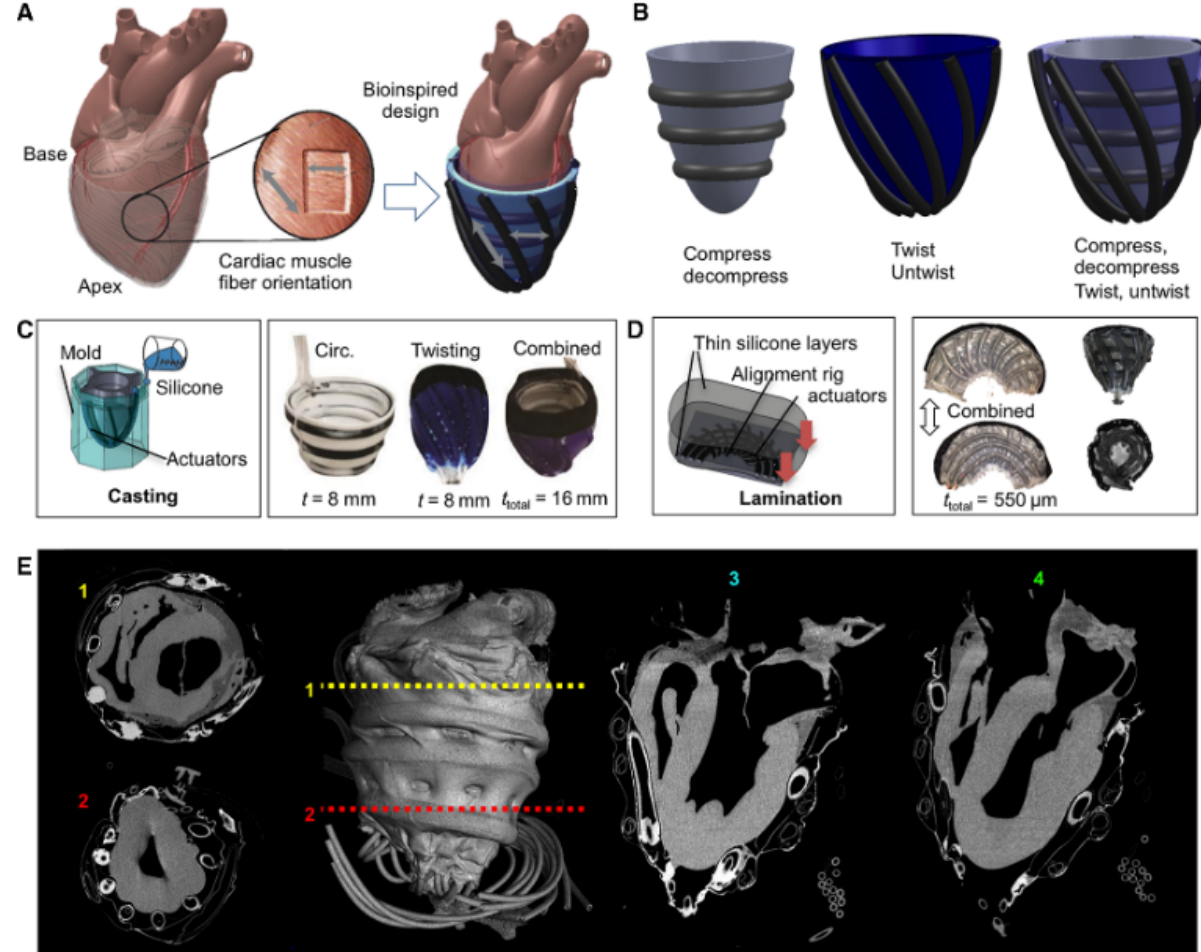
Figure 5: Design and fabrication of a conformal soft robotic sleeve that can compress and